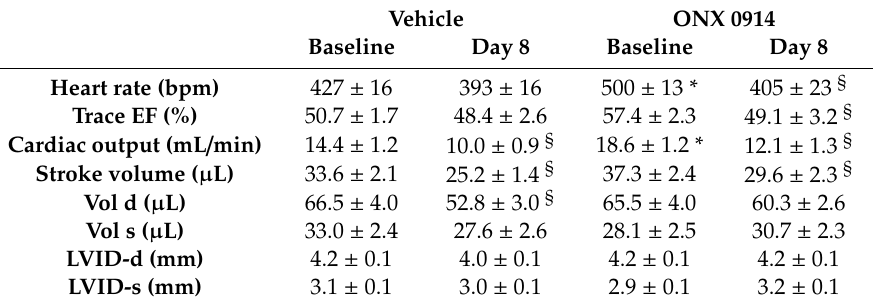
Table 2. Analysis of cardiac function in NMRI mice during acute